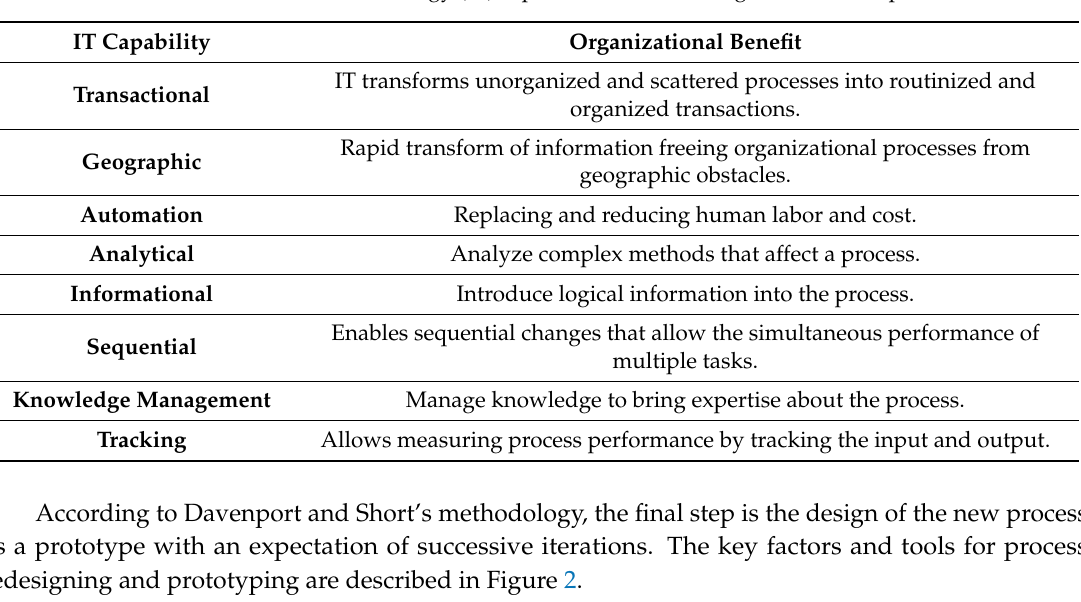
Table 1. Information technology (IT) capabilities and their organizational impact.